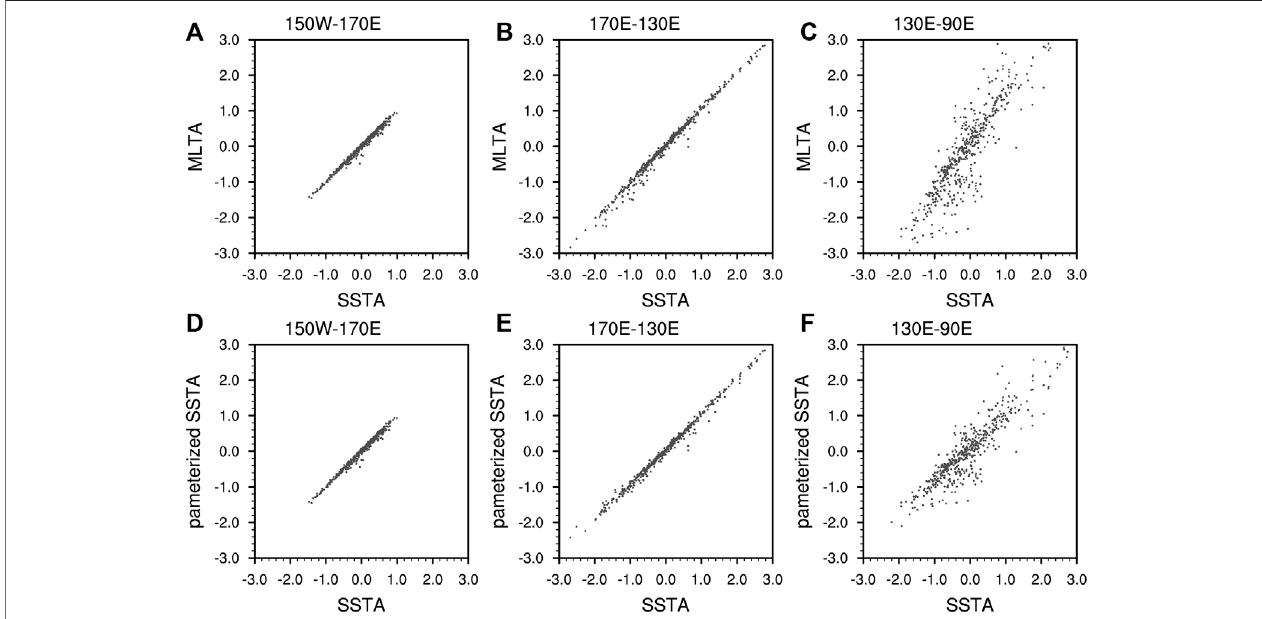
FIGURE 2 | Scatter plot of the observed equatorial (5 ° S – 5 ° N average) SSTA (unit: ° C) vs. MLTA (unit: ° C) averaged over (A) the western Paci fi c, (B) the central Paci fi c, and (C) the eastern Paci fi c during 1979 – 2018. Longitude boundaries of the above three regions are indicated on top of each plot. (D – F) Same as (A – C) but for the scatter plot of the observed and parameterized equatorial SSTA. The observed SSTA and MLTA are obtained from the ORAS5 dataset; the parameterized SSTA is calculatedfrom theobservedMLTA following Supplementary Appendix EquationA10 .MLTA isde fi ned astheanomalous vertical averaged temperature within the upper 50 m.